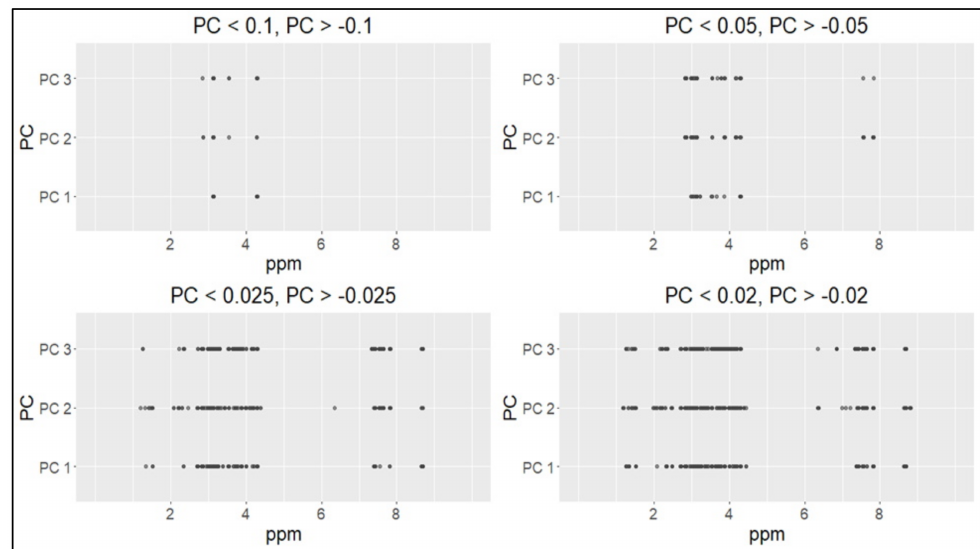
Figure 5. Different thresholds applied to the loadings of the first three principal components.